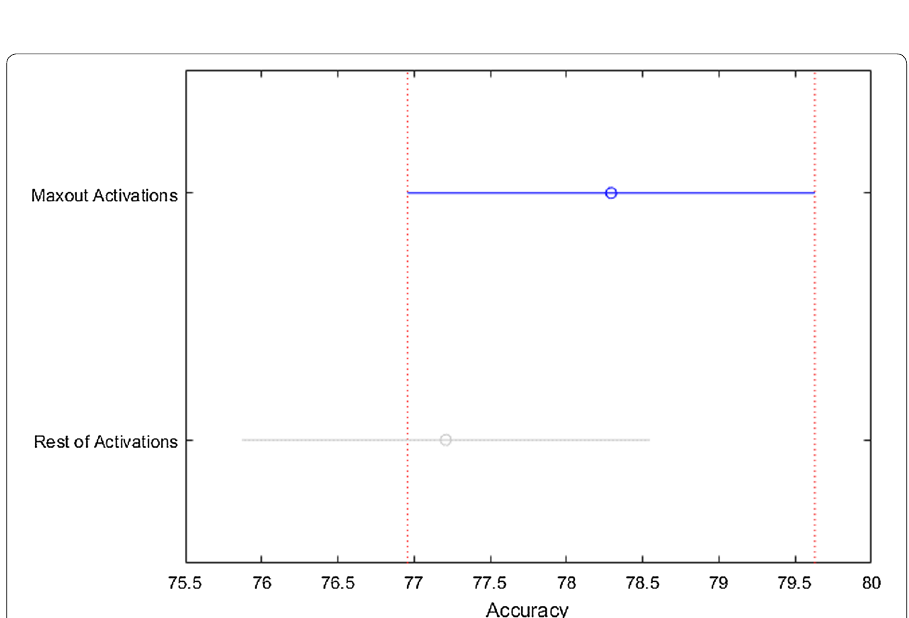
Fig. 10 Multiple comparisons, type of